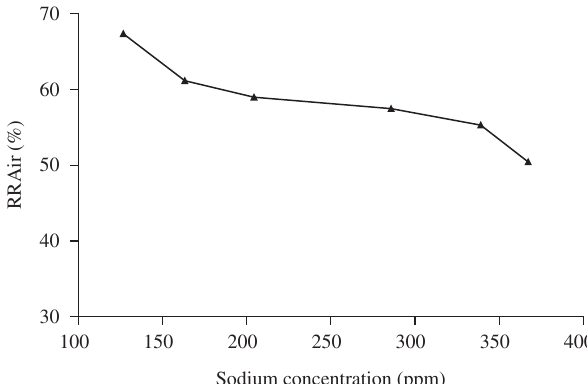
(Q ) as a function of the sodium con- 2 CO2